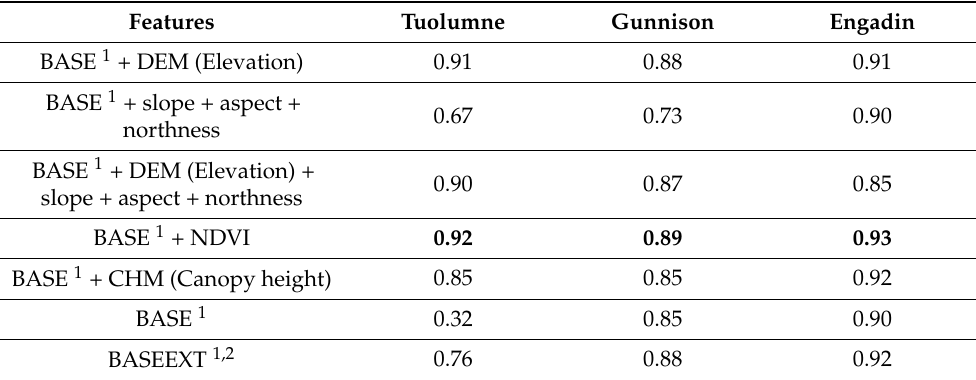
Table 1. F-scores of combinations of features (predictors). Metrics were calculated across 19 scenes (except for BASEEXT which was completed over 16 scenes) in Gunnison, and 2 scenes in Engadin. A scene is approximately 24 km by 8 km.